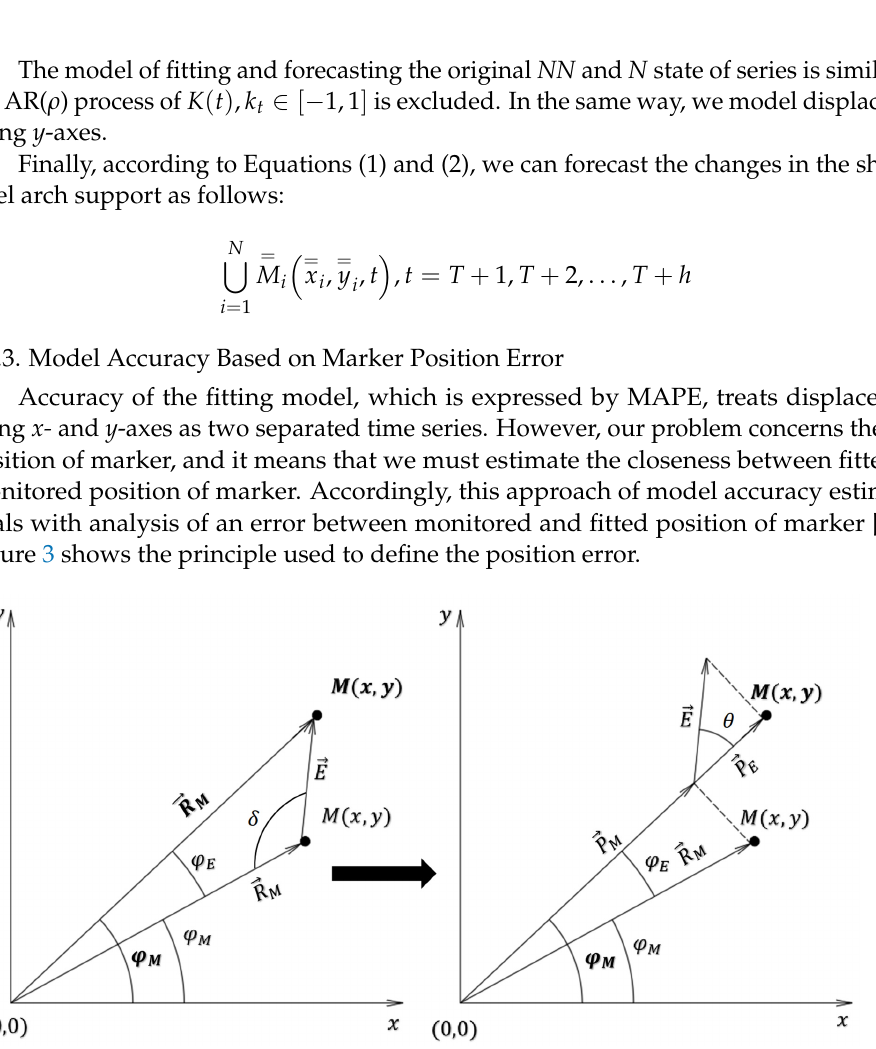
Figure 3. Error between monitored and fi tt ed position of the marker.